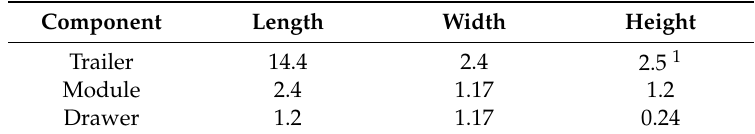
Table 1. Dimensions (m) of the commercial broiler transporters, modules and drawers used in this study.